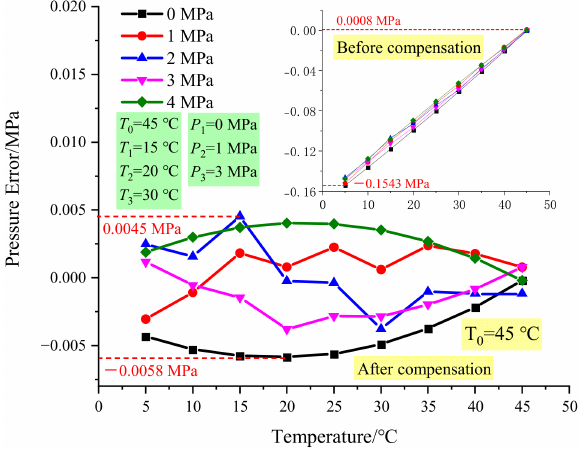
Figure 8. Errors when T 0 = 45 ◦ C.